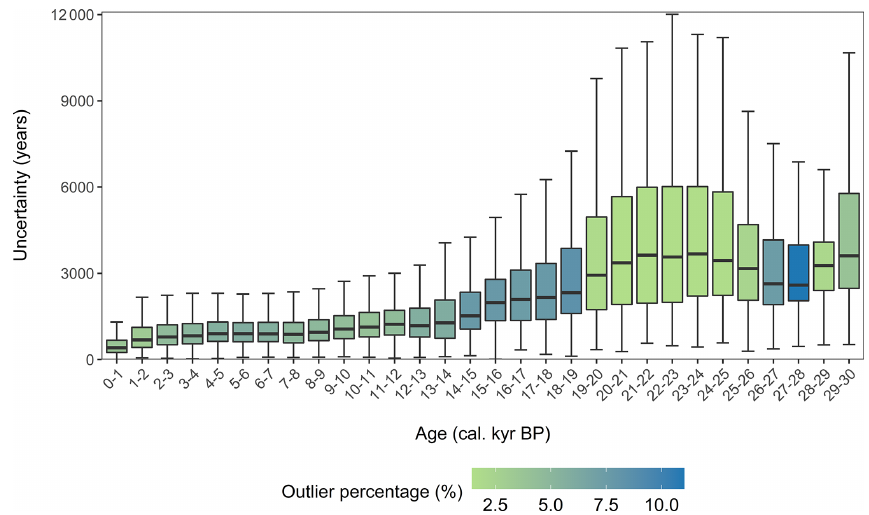
Figure 6. Boxplots of age uncertainties and outlier percentages in distinct time slices.